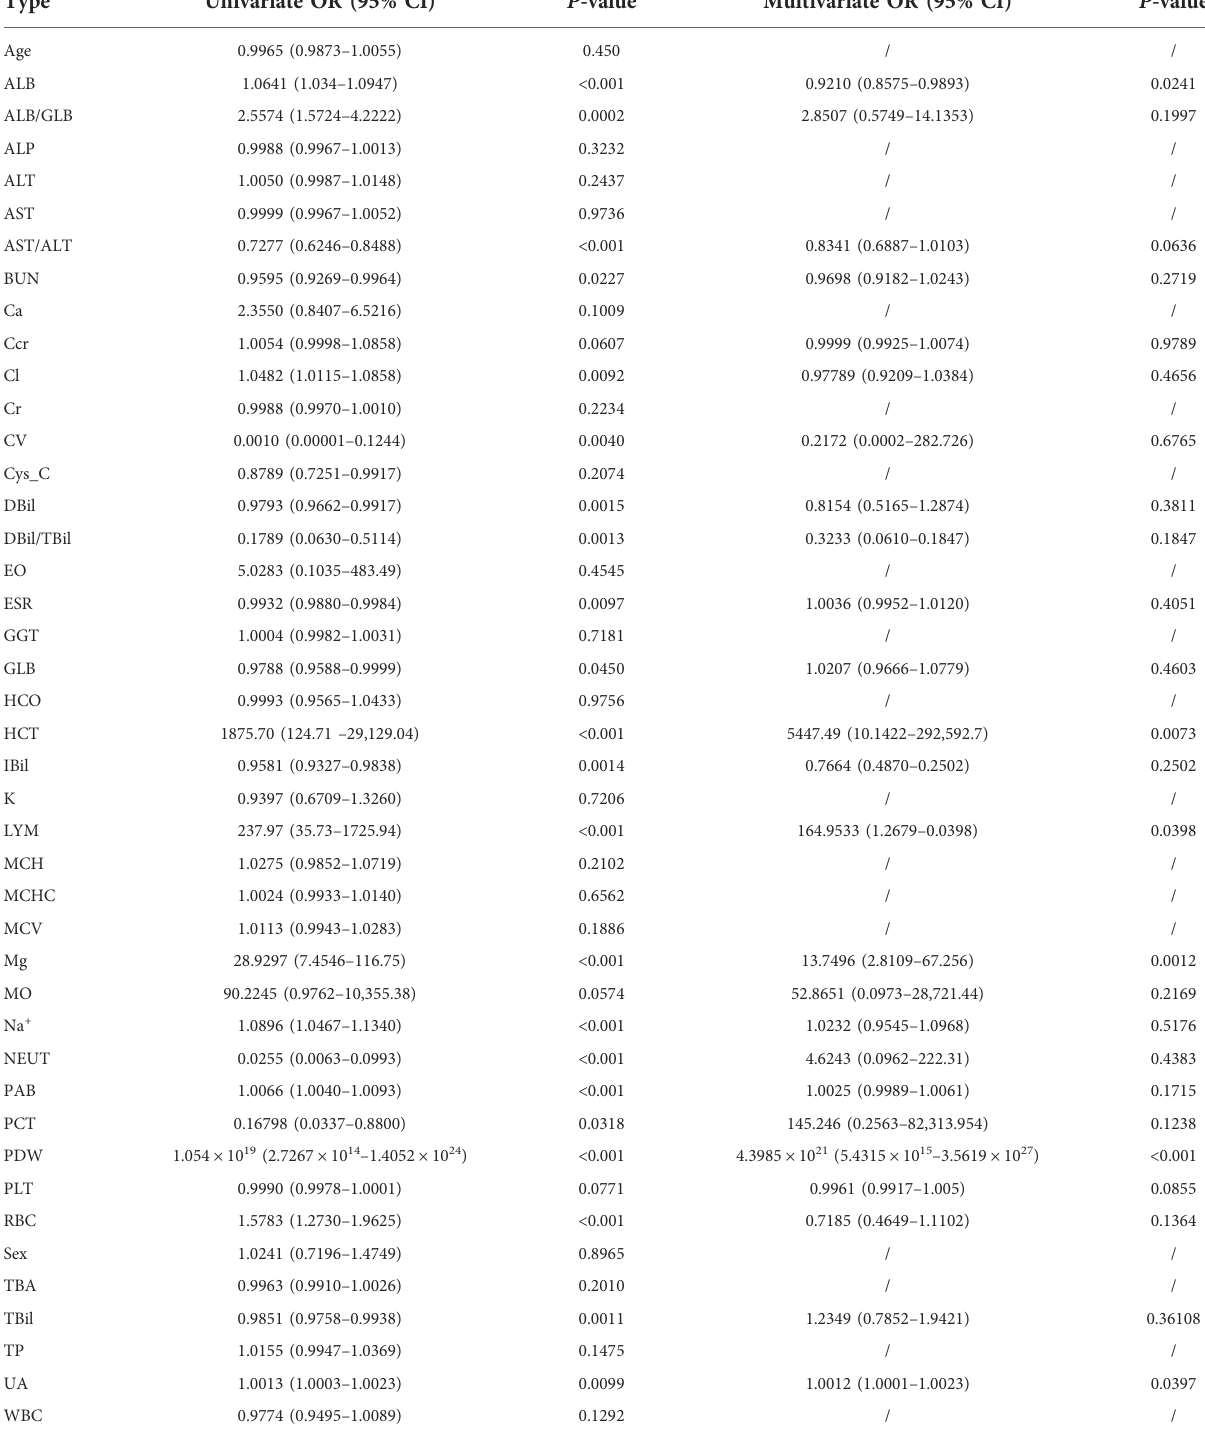
TABLE 4 Univariate logistic regression and multivariate logistic regression predicted bone